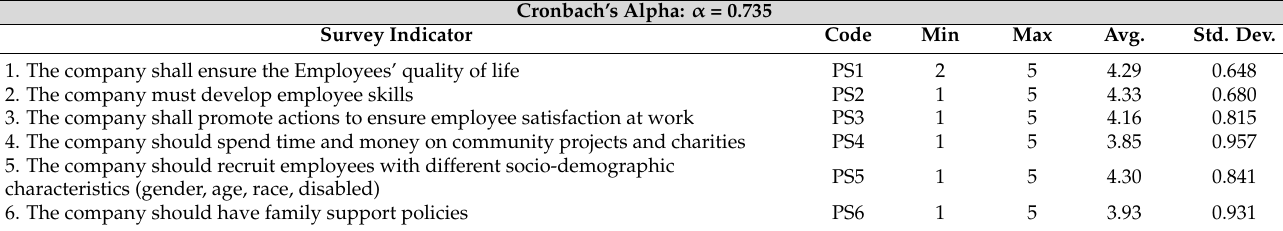
Table 2. Descriptive Statistics of “Social Responsibility Practices” survey